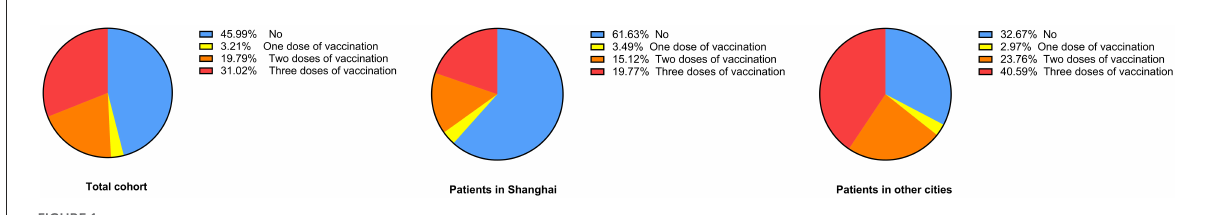
FIGURE1 COVID-19 vaccination status in patients with PD. The COVID-19 vaccination status in patients with PD is shown with one dose of vaccination in yellow, two doses of vaccination in orange and three doses of vaccination in red. The percentage of patients without vaccination is presented in blue.